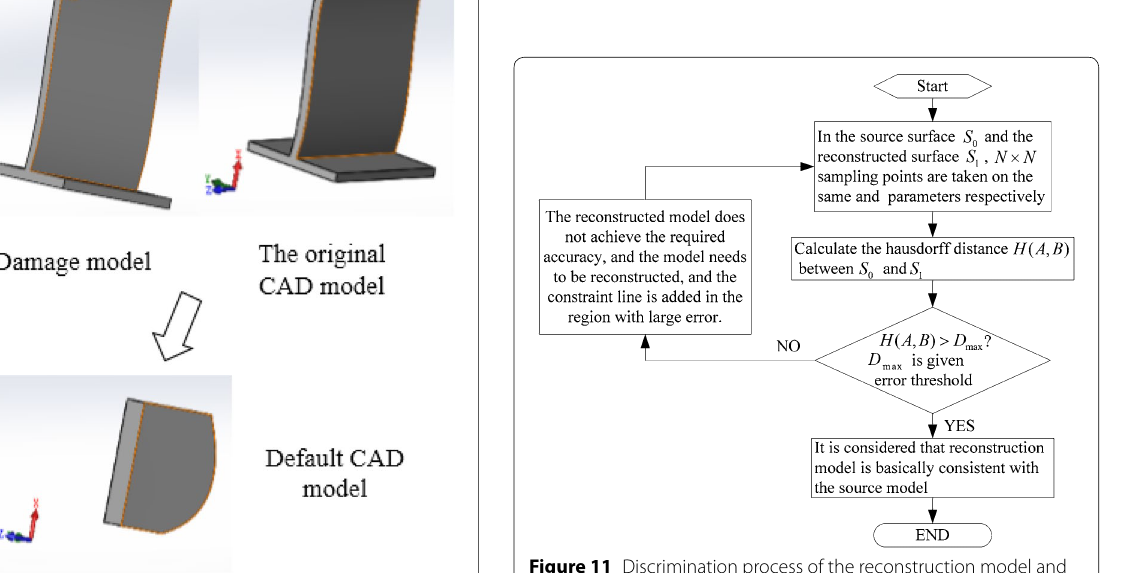
Figure 10 Schematic diagram of damage model reconstruction